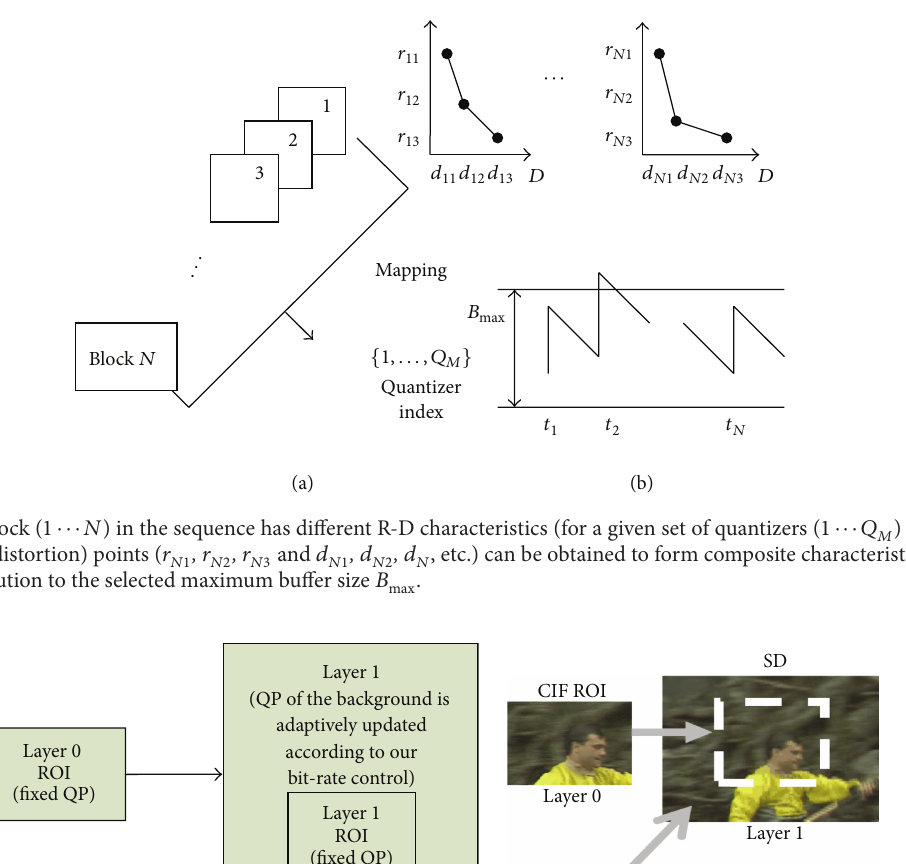
Figure 9: (a) Defining two or more layers with corresponding QPs. The QP of the background region in Layer 1 is determined adaptively by the proposed bit-rate control; (b) CIF ROI is used as base-layer (Layer 0), and 4CIF (SD) is used as an enhancement layer (Layer 1). The intra/inter-prediction is used for reducing the overall